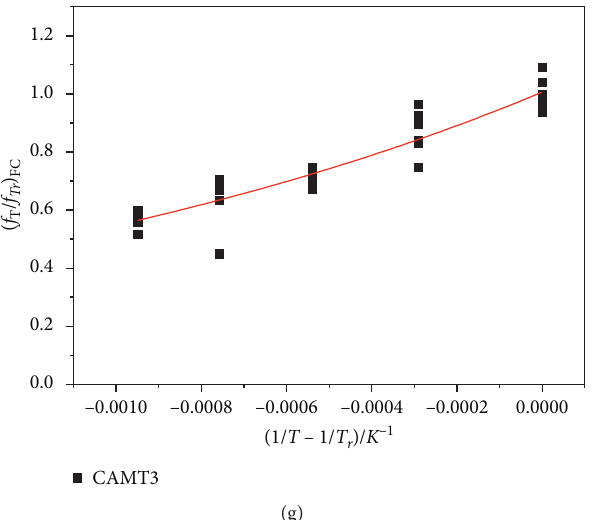
Figure 4: Relationship between ( f CAMT2, and (g) CAMT3.